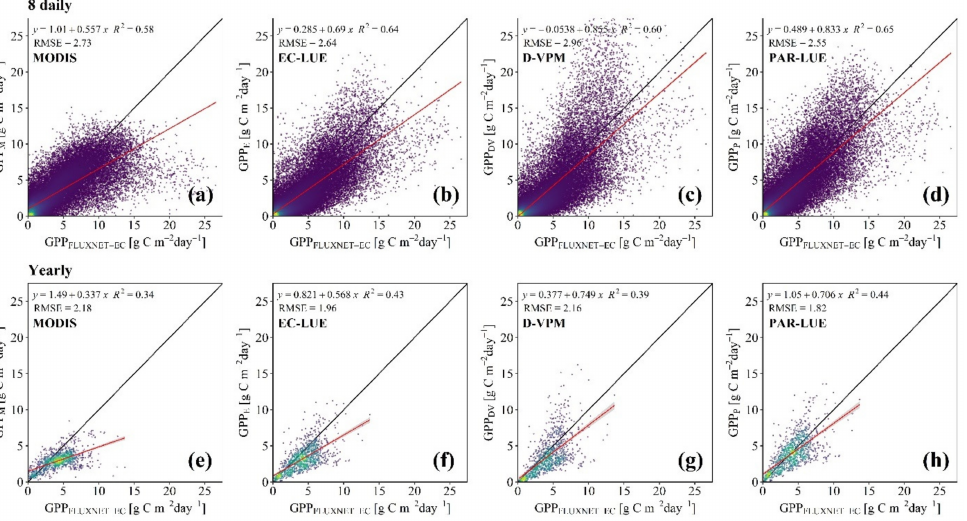
Figure 5. Accuracy comparison of GPP estimated from different LUE models. ( a – d ) show the 8 daily results, and ( e – h ) show the yearly results.